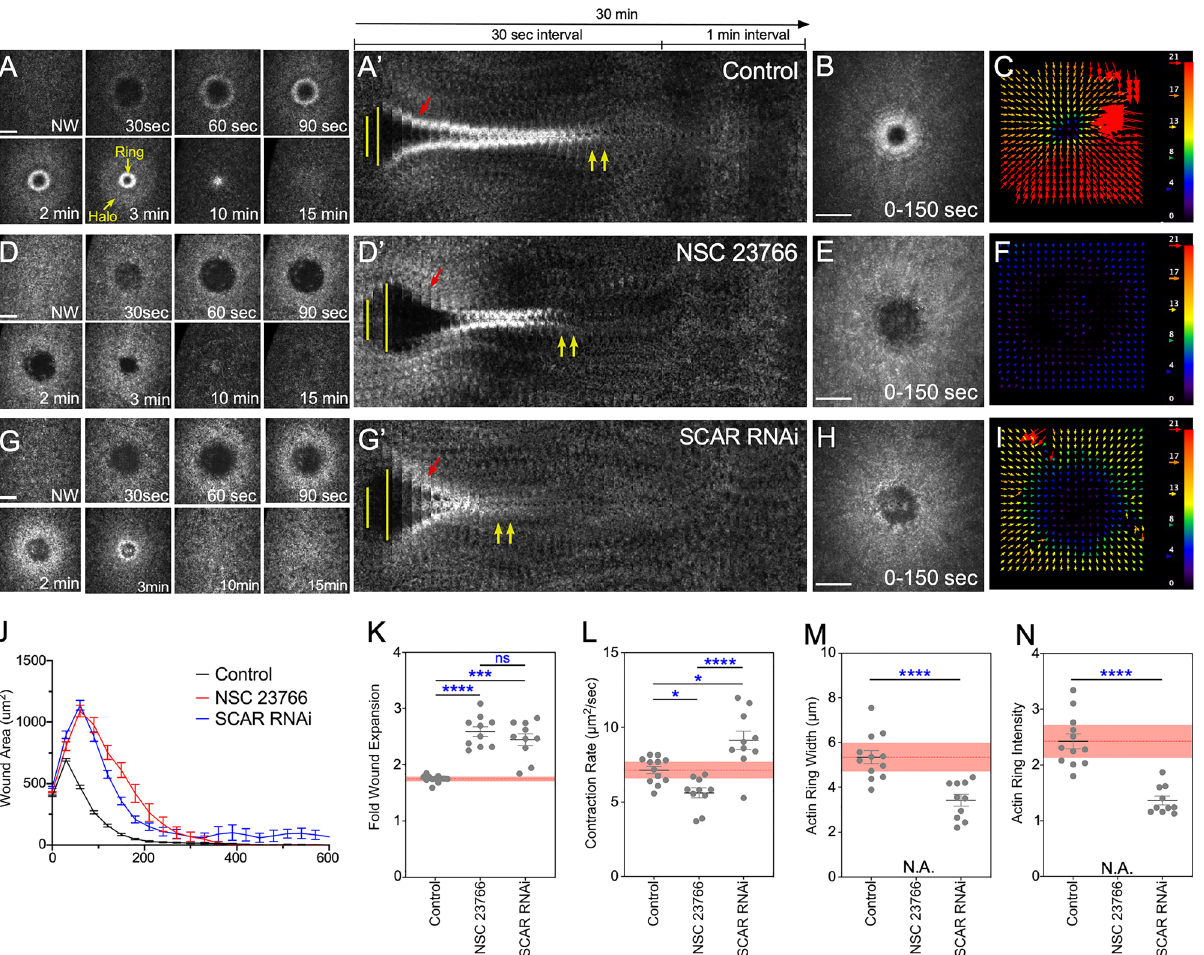
Figure 3. Rac and SCAR knockdowns exhibit different cell wound repair phenotypes. ( A – I ) Confocal projection images of wounds generated in embryos expressing an actin marker (sGMCA) in control (buffer only; A – C ), NSC 23766 injected (potent Rac inhibitor; D – F ), or SCAR RNAi knockdowns ( G – I ). Actin ring and halo are indicated in ( A ). ( A’ , D’ , G’ ) Kymographs across the wound area in ( A , D , G ), respectively. Wound expansion is noted with yellow lines; actomyosin ring formation with red arrows; and actomyosin ring disassembly with yellow arrows. ( B , E , H ) XY projection image at 0–150 s post wounding showing cortical flow of actin to the wound edge. ( C , F , I ) Vector maps from PIV (Particle Image Velocimetry) analysis depicting actin flow from 60 to 90 s for ( A , B , D , E , G , H ) respectively. ( J ) Quantification of the wound area over time for control (buffer injected), NSC 23766 injected, and SCAR RNAi knockdowns. ( K – N ) Quantification of fold wound expansion ( K ), wound contraction rate ( L ), actin ring width ( M ), and actin ring intensity ( N ). Black line and error bars represent mean ± SEM. Red dotted line and square represent mean ± 95% CI from control. Kruskal– Wallis test ( K – L ) and Welch’s t-test ( M – N ) were performed with * is p < 0.05, ** is p < 0.01, *** is p < 0.001, **** is p < 0.0001, and ns is not significant. Scale bars: 20 μm.